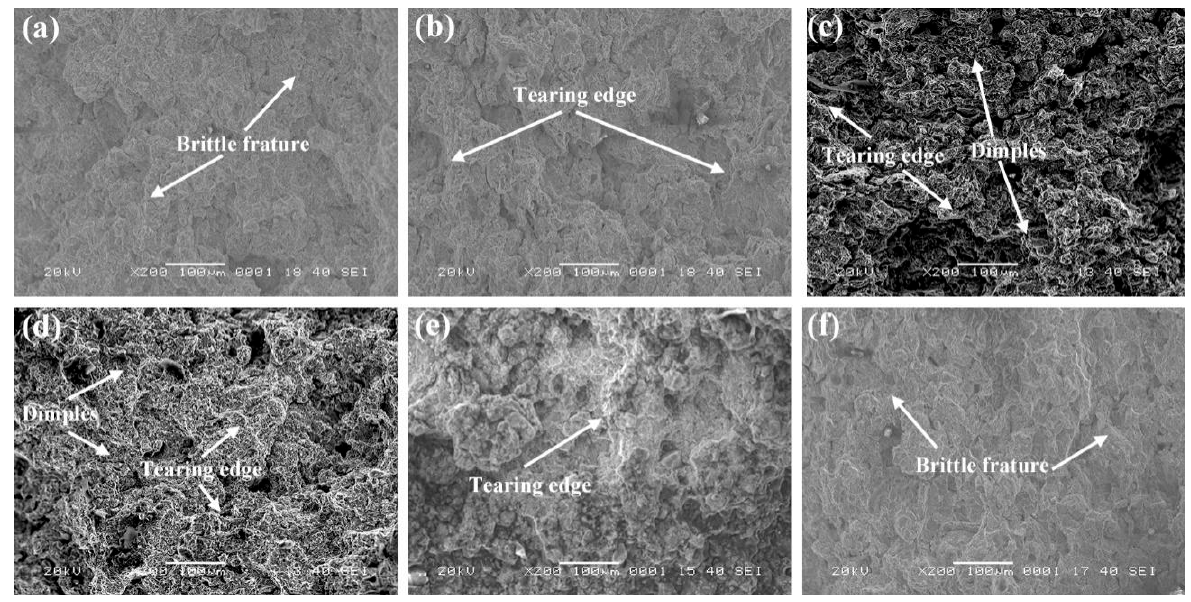
Figure 7. Fracture morphologies of the sintered matrixes with different Ni contents: ( a ) Ni-free, ( b ) with 3 wt.% Ni, ( c ) with 6 wt.% Ni, ( d ) with 9 wt.% Ni, ( e ) with 12 wt.% Ni, ( f ) with 15 wt.% Ni.